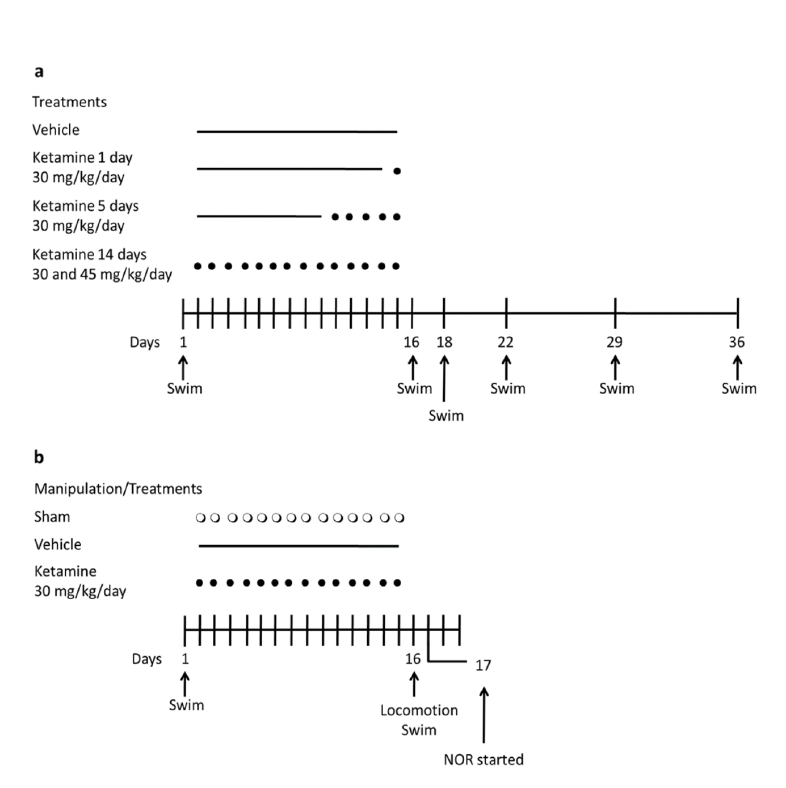
Figure 1 - Experimental schedules used in this work. a ) Evaluation of the effect of different doses and periods of treatment with ketamine on the immobility of animals exposed to forced swim. b ) Evaluation of ketamine repeated treatment on locomotion and novel object recognition task. o Gentle handling; - vehicle administration (saline